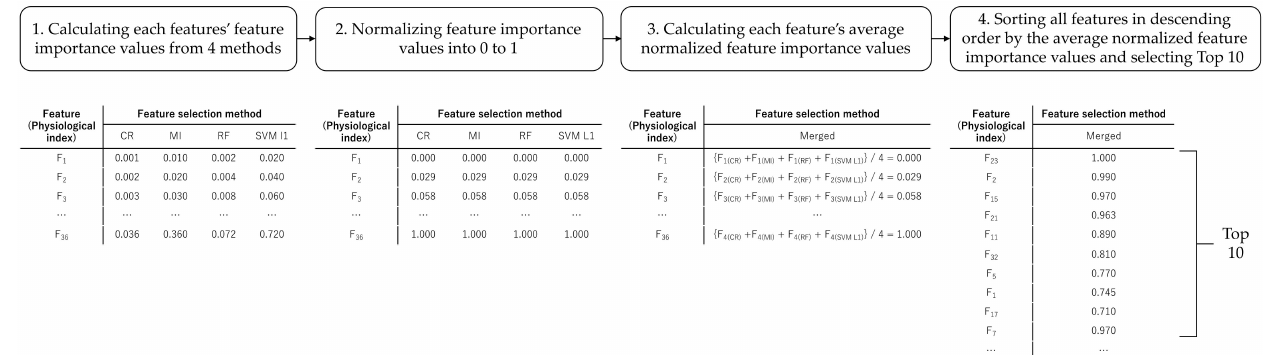
Figure 6. The illustration of the procedure of feature selection ensemble from the calculation of feature importance values by integrating the four feature selection methods to the selection of top 10 important features.